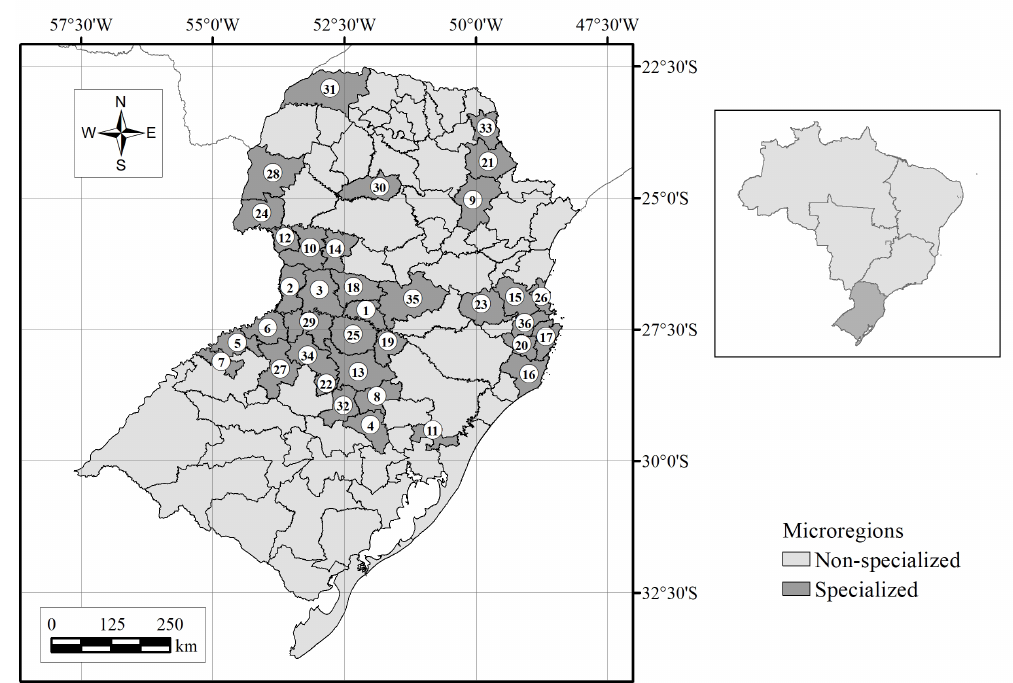
Figure 1. Microregions specialized in milk production in Southern Brazil. Notes: 1.